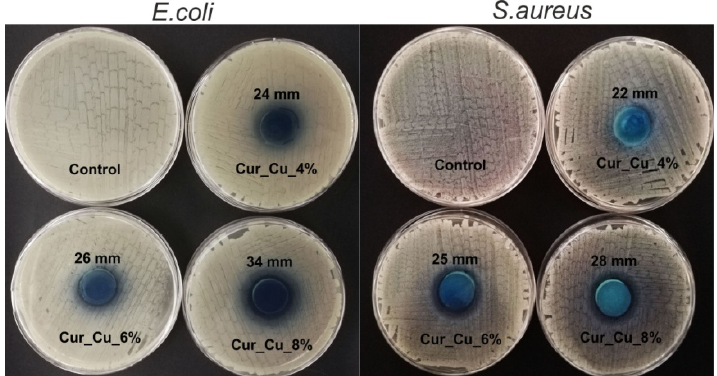
Figure 5. Representative images presenting zones of E. coli and S. aureus growth inhibition around Cur_Cu_4%, Cur_Cu_6%, and Cur_Cu_8% biomaterials. The diameter of samples was equal to 22 mm.